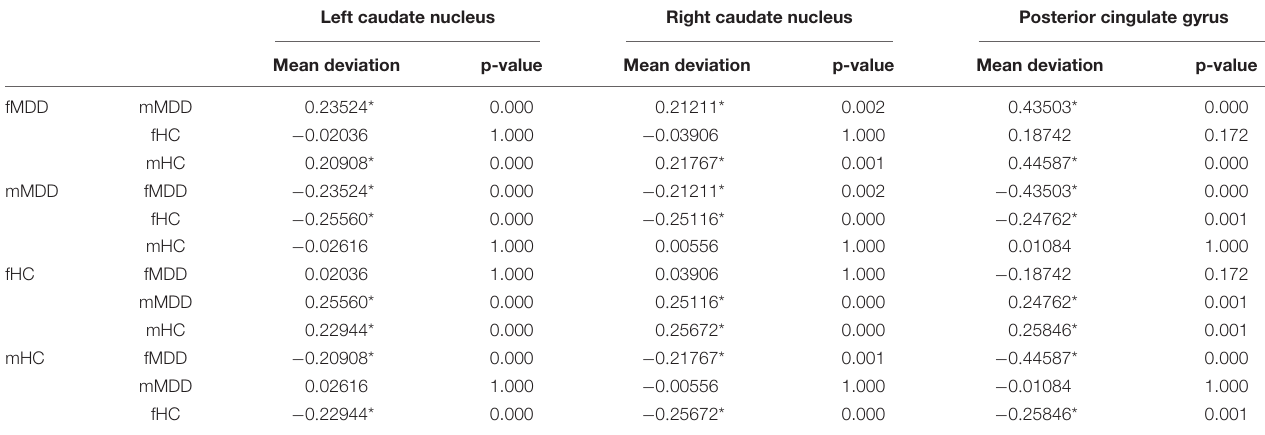
TABLE 3 | Post hoc comparisons of amplitude of low-frequency fluctuation (ALFF) among four groups. Left caudate nucleus Right caudate nucleus